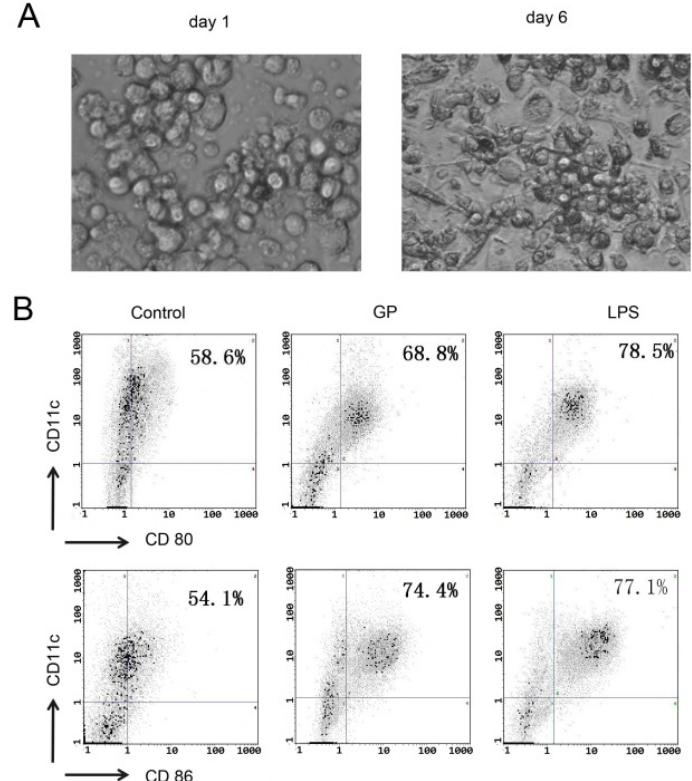
Figure 1. Effects of GP on phenotypic maturation of DCs. Hematopoietic progenitor